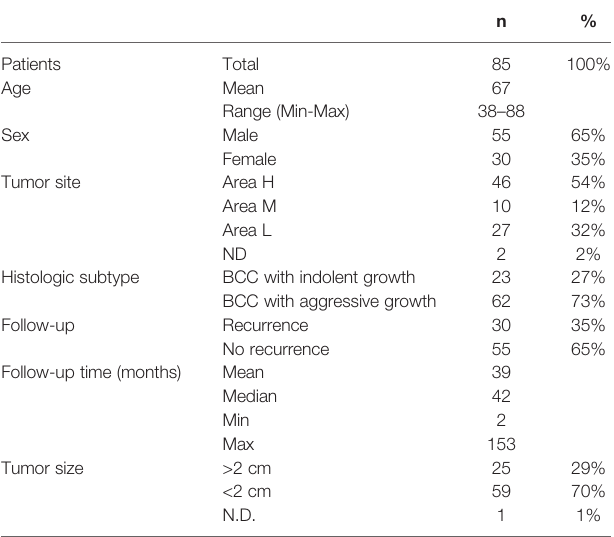
TABLE 2 | Clinical-pathologic characteristics of the study population.